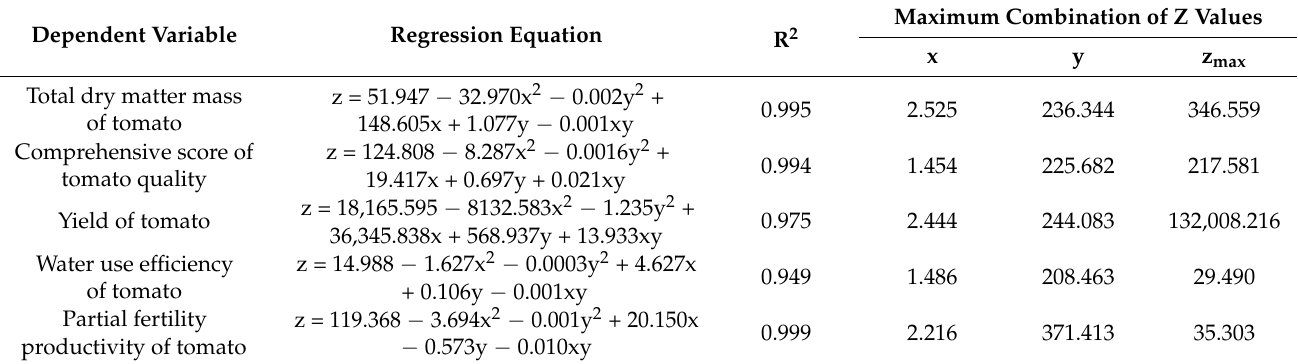
Table 8. Multiple regression analysis.